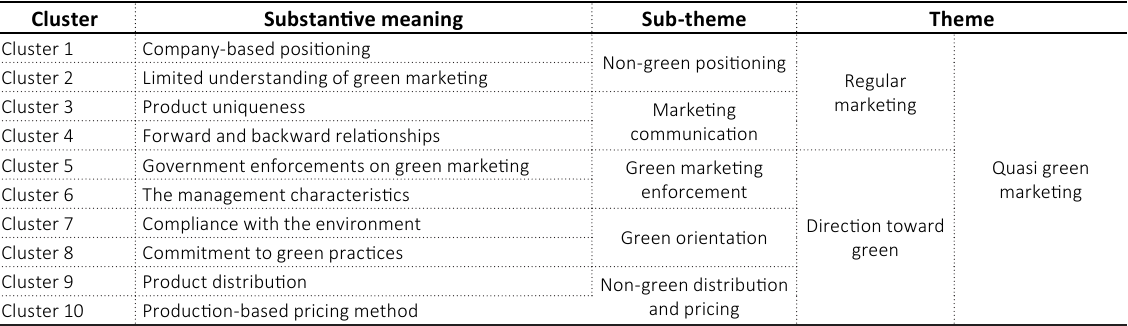
Table 12. Themes between